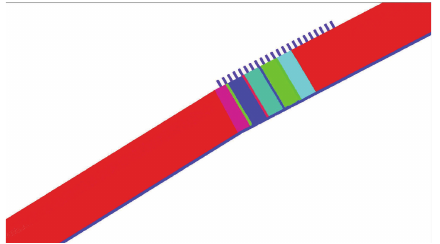
Figure 3: View of a typical mesh for the entire domain.